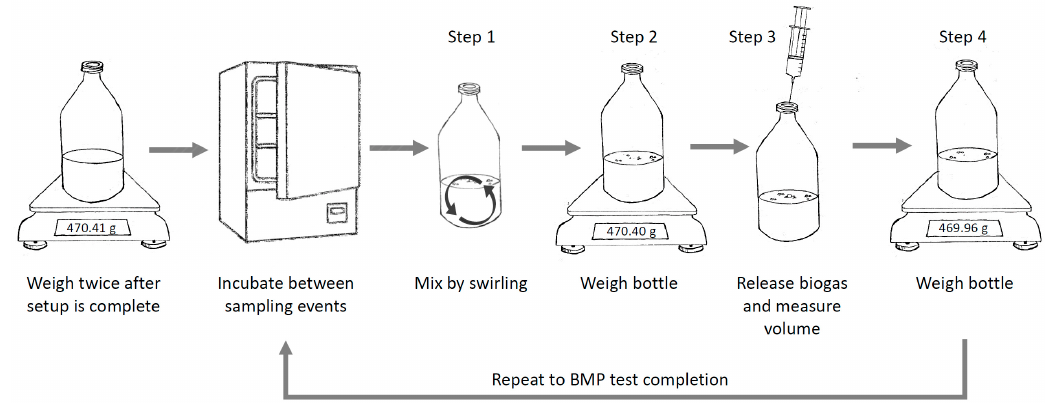
Figure 1. The data collection steps required for gas density-based BMP (GD-BMP) measurements. Step numbers match those listed in the text, and are repeated for each sampling event.